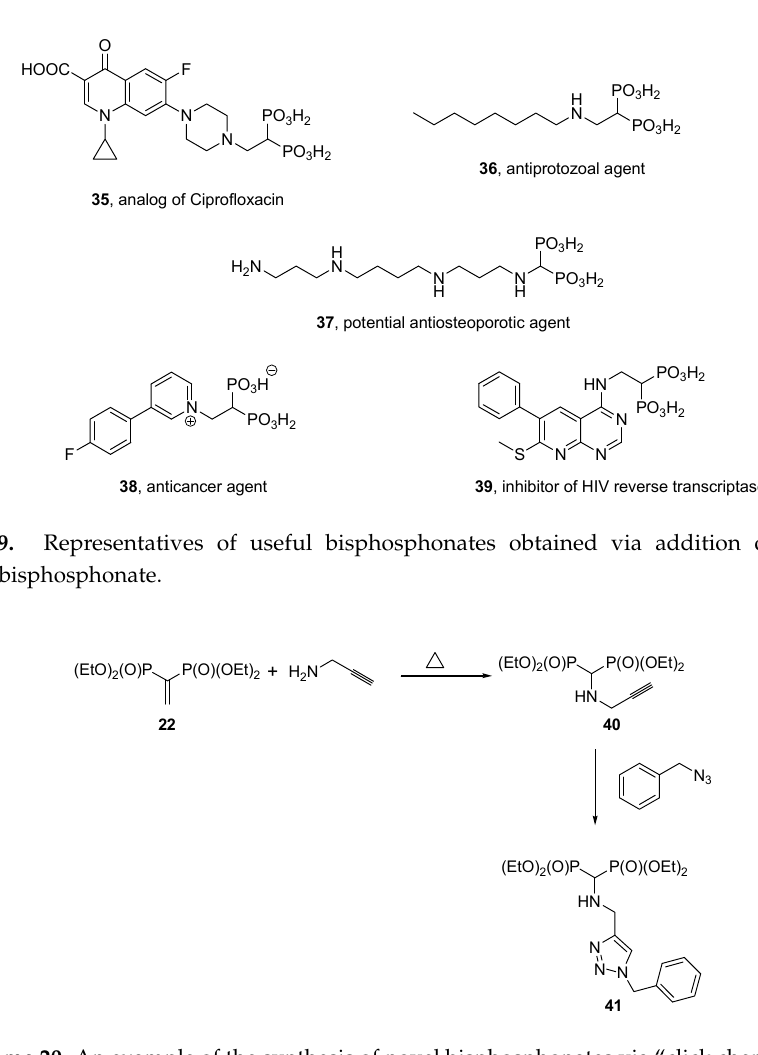
Scheme 20. An example of the synthesis of novel bisphosphonates via “click